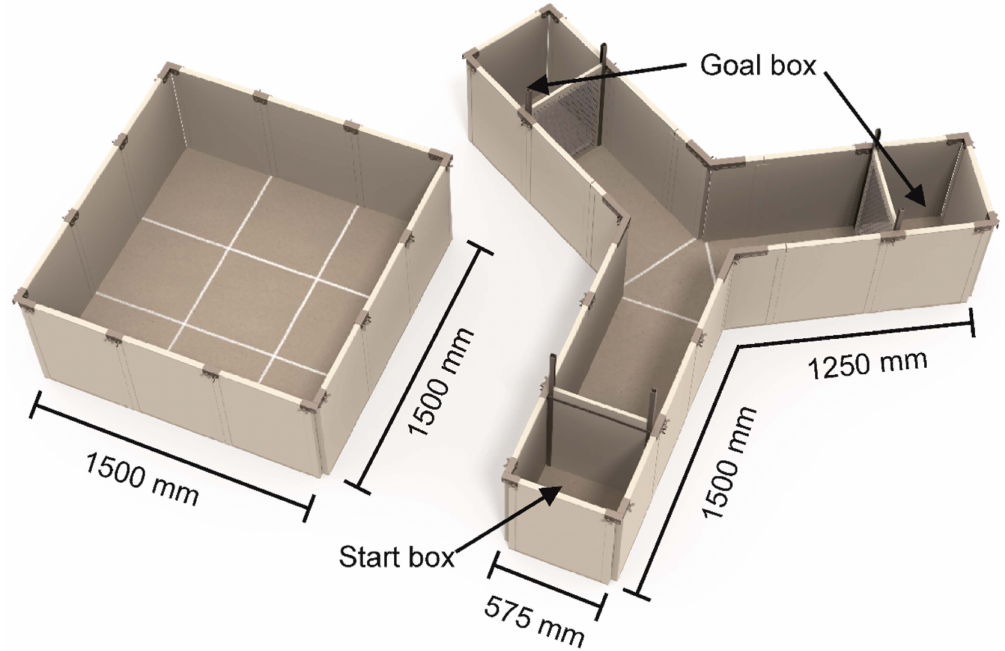
Figure 2. Open field (left panel) and the Y-maze (right panel). Chicks were placed in the center of the OF, and behavior was monitored for 10 min. The Y-maze apparatus consisted of one long arm and two short arms. The end compartment, goal box, of each short arm contained either a social stimulus or a foraging stimulus. The test chicken was placed in the start box, and the test of 10 min began when the guillotine door of the start box was pulled via a lever system. White chalk lines divided the apparatus in sub-compartments that could be used for analysis. Illustrations: Yorrit van der